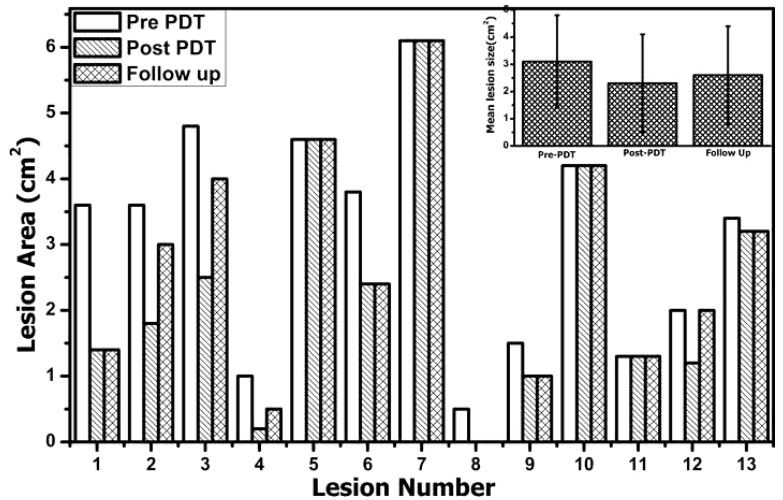
Fig. 4. Size OL lesion at pre-, post-PDT and follow-up conditions.